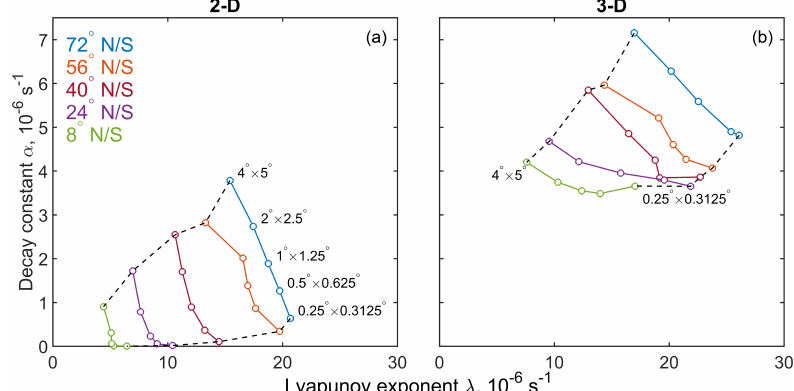
Figure 7. Variation of the plume decay constant ( α ) in 2-D and 3-D simulations as a function of latitude and the Lyapunov exponent of the flow ( λ) . Each point shows the mean value of α and λ over the 9-day plume aging time in the free troposphere, averaging over all plumes at a given latitude in both hemispheres. Each colored line shows results from all five resolutions as individual circles. Dashed black lines show the effect of increasing absolute latitude for the resolution endpoints (0.25 ◦ × 0.3125 ◦ and 4 ◦ × 5 ◦